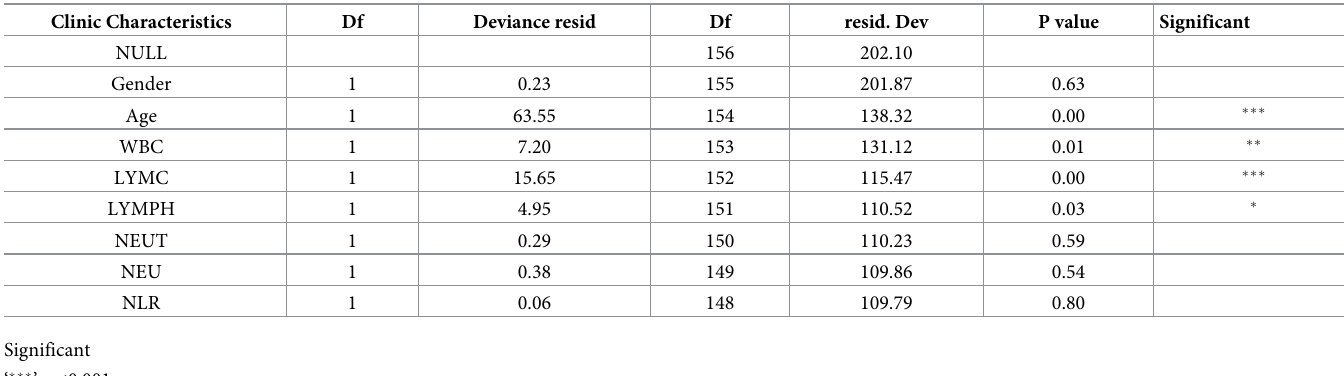
Table 3. Dispersion analysis of clinical